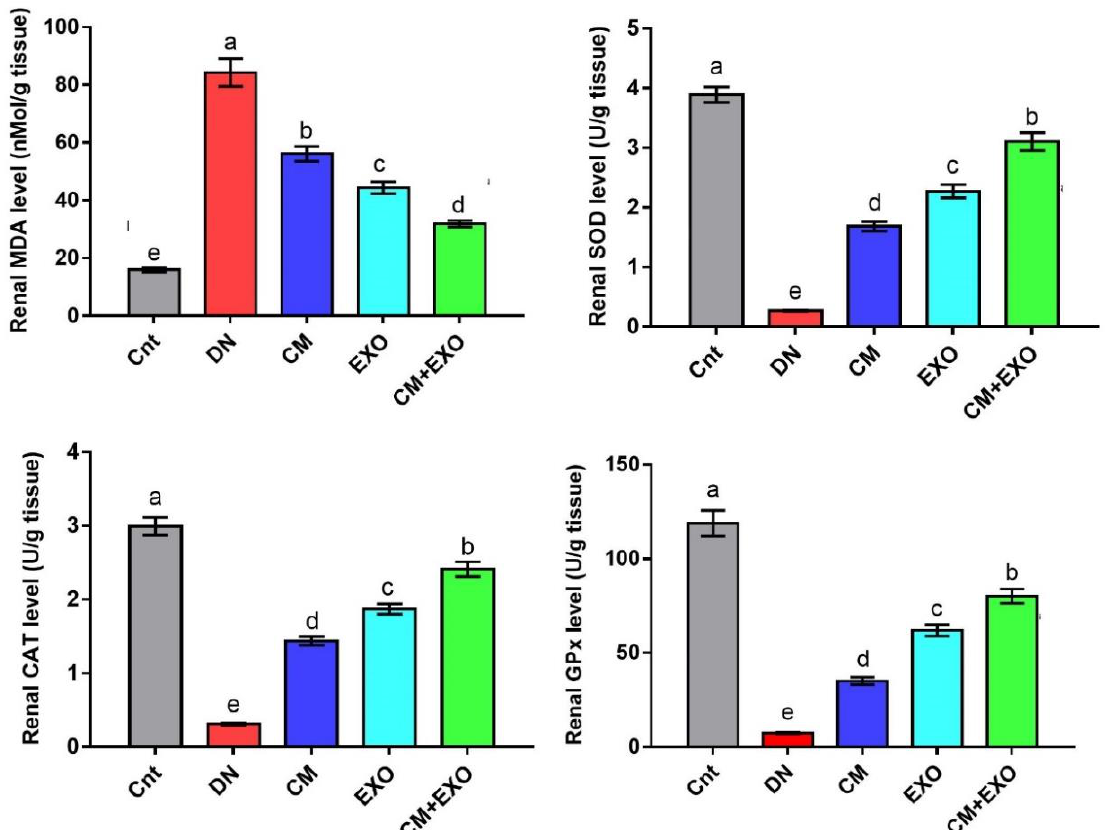
Figure 2. Effect of camel milk and/or its EXOs on oxidative stress (MDA) and antioxidant (SOD, CAT, and GPx) status in rat renal tissue. Values were expressed as mean ± SEM (n = 6/group). Columns carrying different letters (a (the highest value)–e (the lowest value)) are significantly different at p < 0.05. All groups were compared to each other. Each data point represents an average of three independent experiments with three replicates for each. Cnt, control group; DN, diabetic nephropathy group; CM, camel milk-treated group; EXO, camel milk exosomes-treated group; CM + EXO, co- treated group with camel milk and its